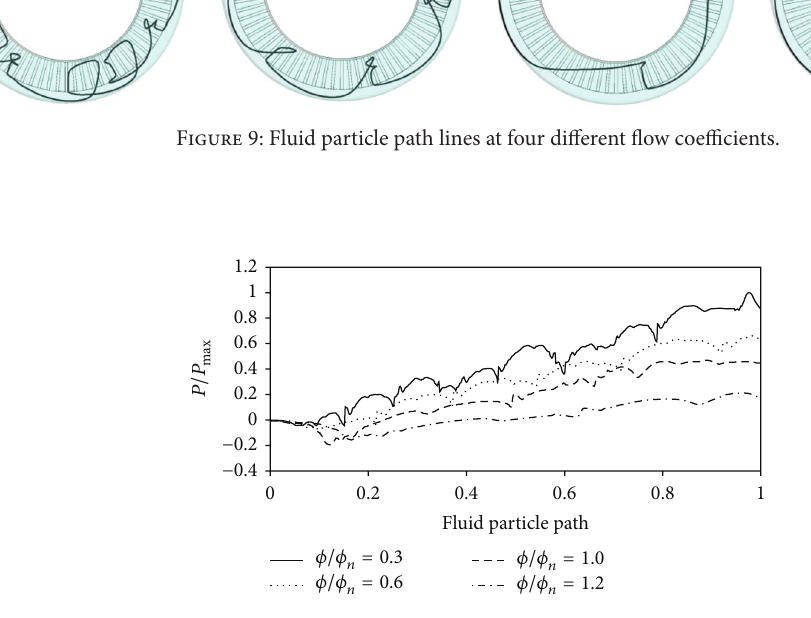
Figure 10: Comparison of pressure variation along a particle path line for four flow